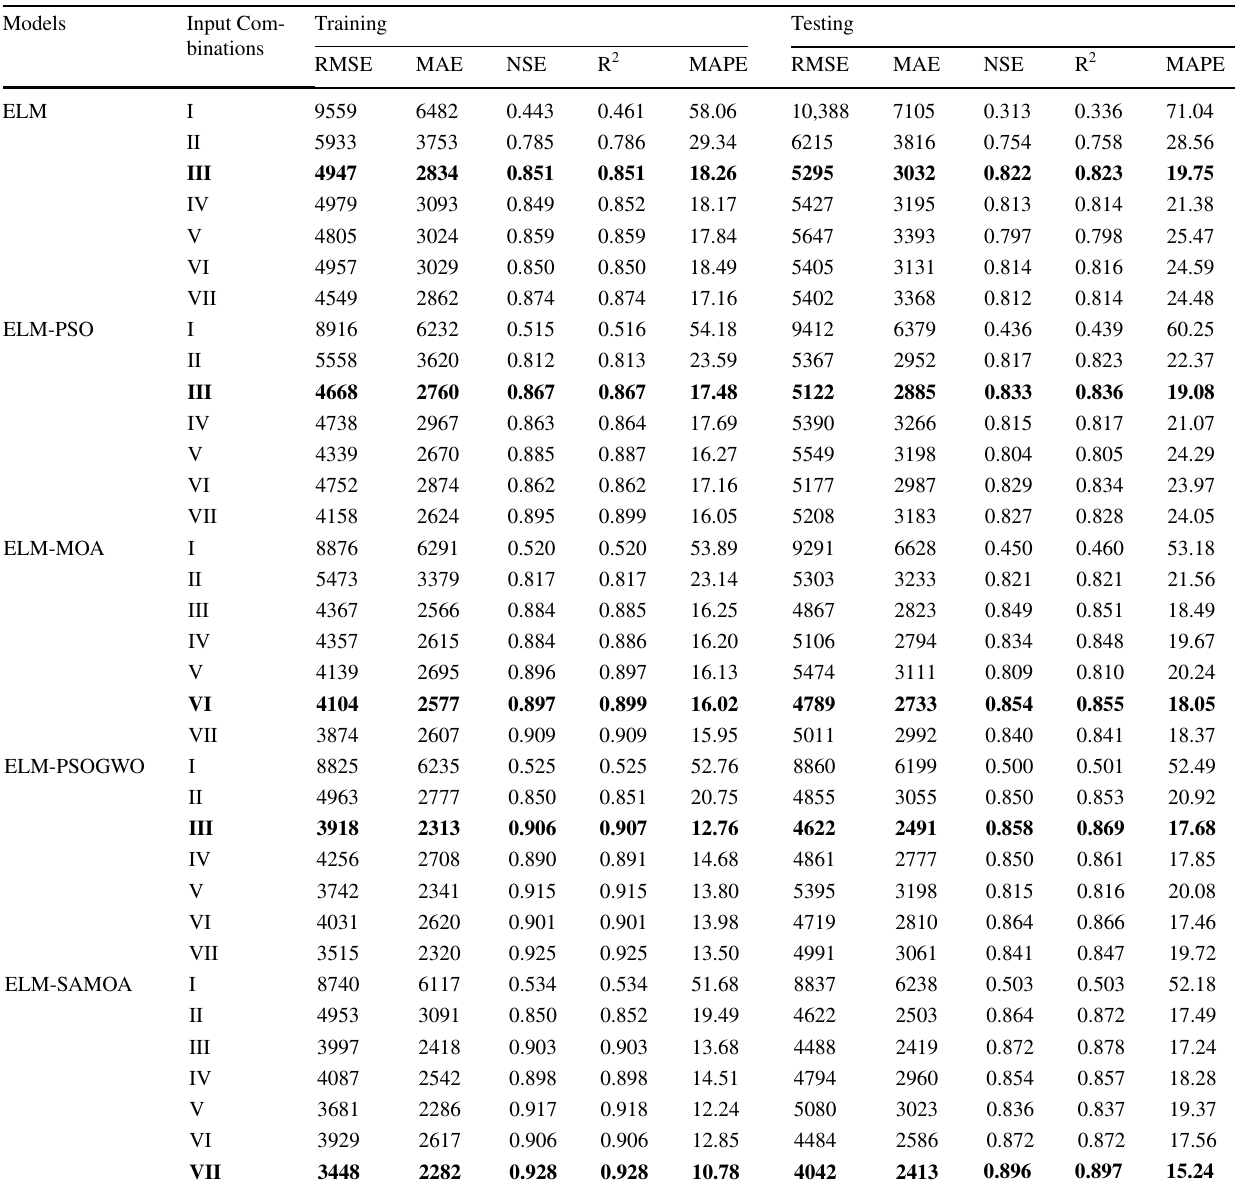
Bold values defines the best accuracy (meaning the slowest RMSE and MAE and highest NSE